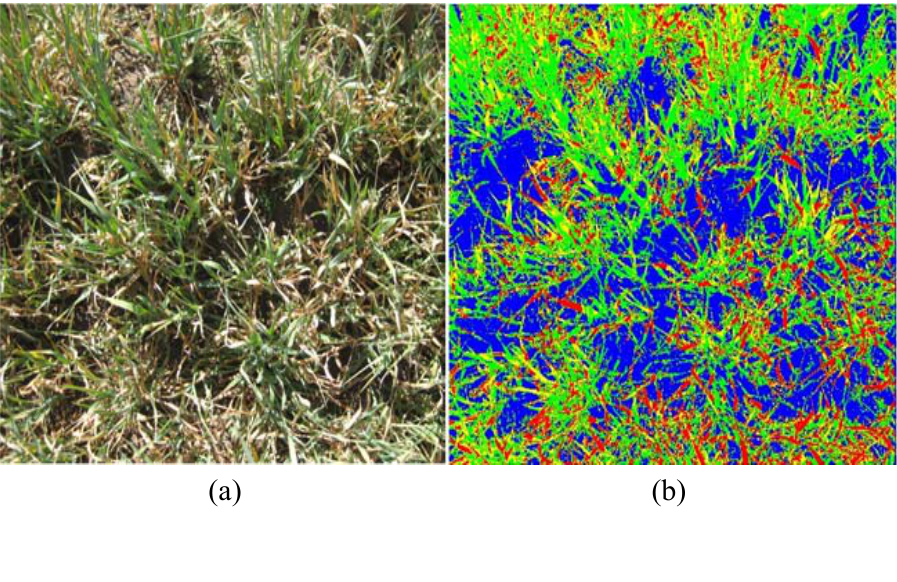
Figure 2. (a) Original digital image; (b) Classification results obtained by the unsupervised strategy (four